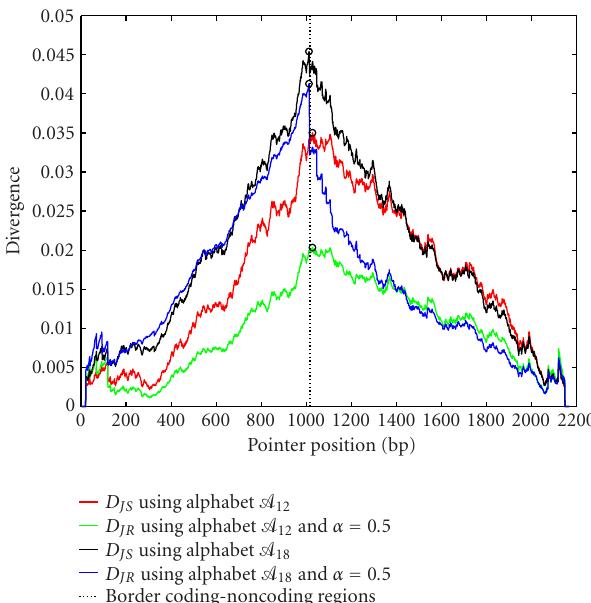
Figure 9: Jensen-Shannon divergence and Jensen-R´enyi divergence versus cutting position for a DNA sequence containing a randomly chosen coding region and a randomly chosen noncoding region.